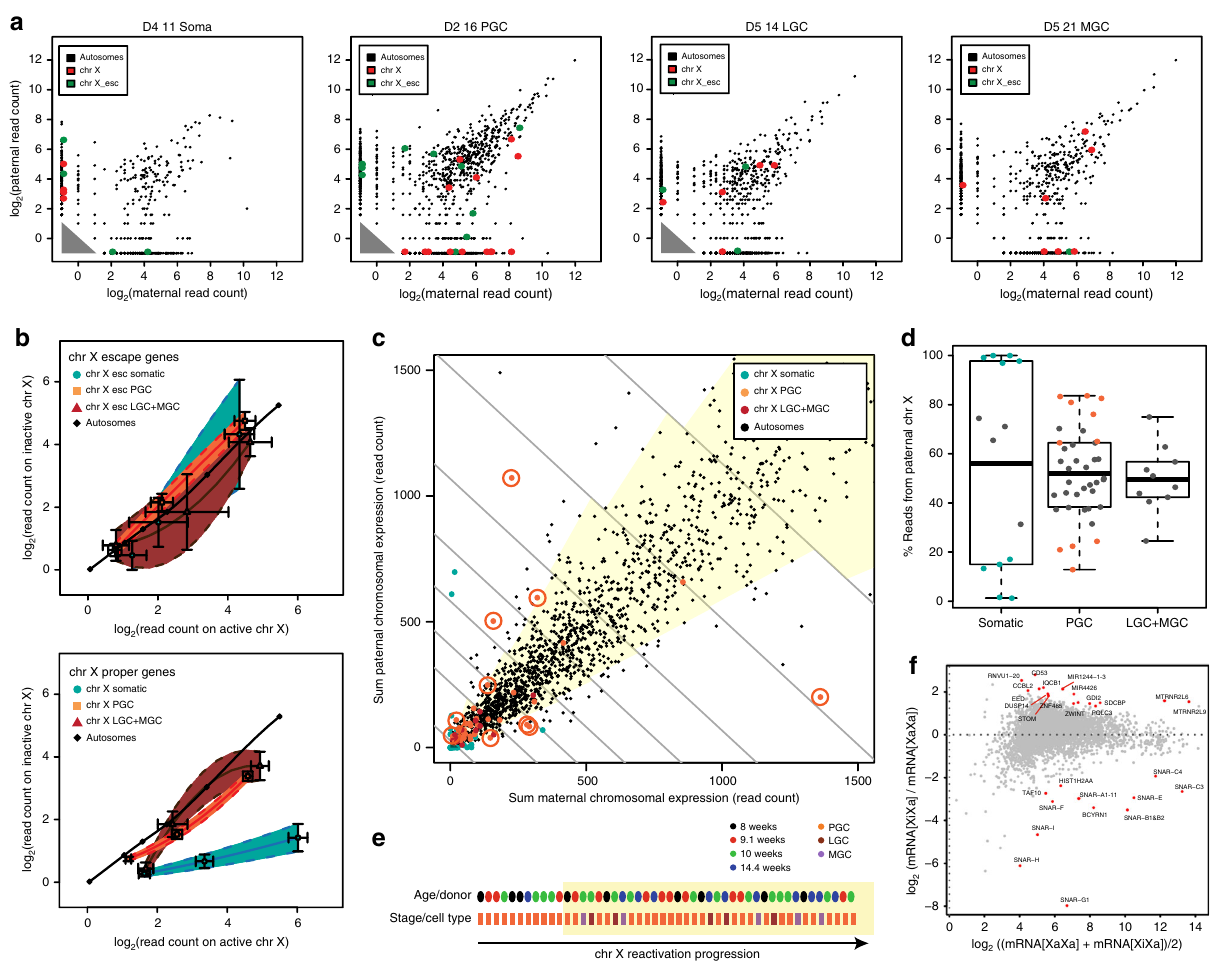
Fig. 4 Parent-of-origin allele-speci fi c expression of X-linked genes in human germ cells reveals incomplete X reactivation. a Examples of a somatic cell and germ cells at different developmental stages showing the maternal and paternal expression of SNP-containing autosomal genes (black dots), proper (non- escapee) X-linked genes (red dots) and X-linked genes know to escape inactivation (green dots). b Distribution of pooled allele-speci fi c read counts of SNP-containing XCI-escaping genes (top) and X-proper genes (bottom) on the active and inactive X chromosome per cell type. The average ± standard error of the mean (SEM) is shown for each bin. c Allelic bias of individual autosomes (black) and sex chromosomes (colored by cell type and stage). The sum of maternal and paternal allele-speci fi c read counts of SNP-containing genes per chromosome per single cell shows different degrees of reactivation. Chromosomes are binned per total allelic read counts (gray lines) to counter sequencing depth related technical effects. The yellow area in each bin is the 95% con fi dence interval as de fi ned by allelic bias in autosomes. X chromosomes in orange circles are from germ cells that fall outside the 95% interval, therefore are signi fi cantly non-reactivated. Analysis pipeline depicted in Supplementary Fig. 6a and displayed in log-space in Supplementary Fig. 6b. The read counts of the X chromosome exclude reads from escapee genes. d Percentage of reads from the paternal X chromosome per cell type. Data points corresponding to cells that show signi fi cant allelic expression bias on the X chromosome (fell outside the 95% interval in Fig. 4c) are colored. The broken lines indicated the 25% quartiles. e Individual germ cells ranked according to their X chromosome expression bias (reactivation status). Cells are colored according to fetal age (top) and germ cell stage (bottom). X chromosomes in the yellow area are within the 95% con fi dence interval determined by the autosomes. f Differential gene expression between PGCs that contain X chromosomes with allelic expression bias comparable to autosomes (XaXa) and PGCs that are reactivating the silent X chromosome (XiXa). Red dots (with gene names) were signi fi cantly differentially expressed ( p < 0.05). P values were calculated using negative binomial distribution and corrected for multiple testing by the Benjamini-Hochberg